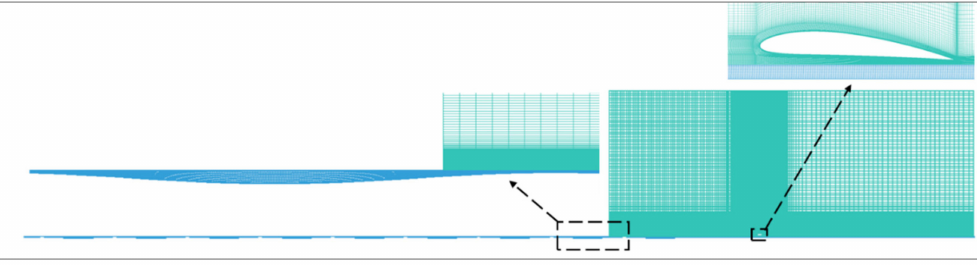
Figure 2. Grid for computational